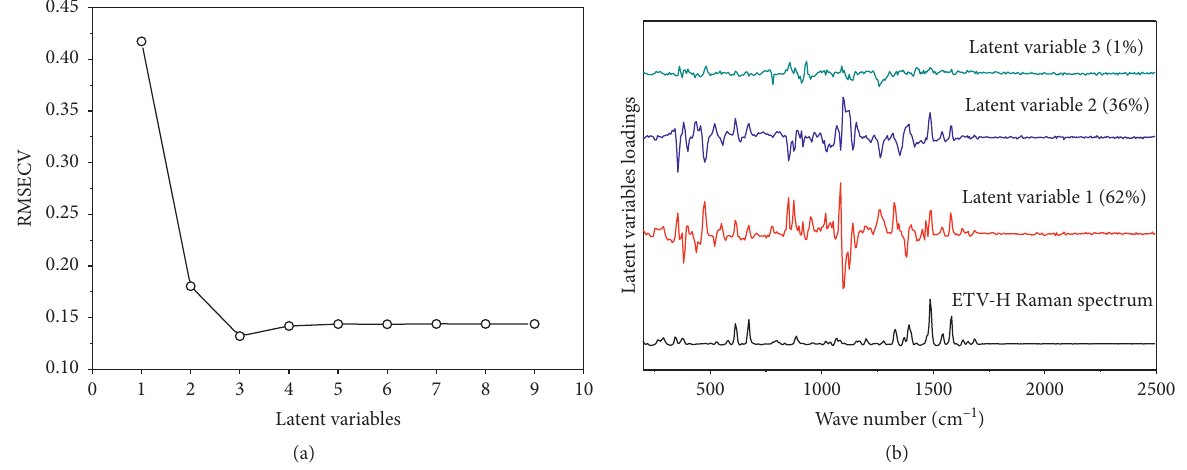
Figure 4: (a) RMSECV values vs. the latent variables for the PLS model. (b) Latent variables loadings plot for the PLS